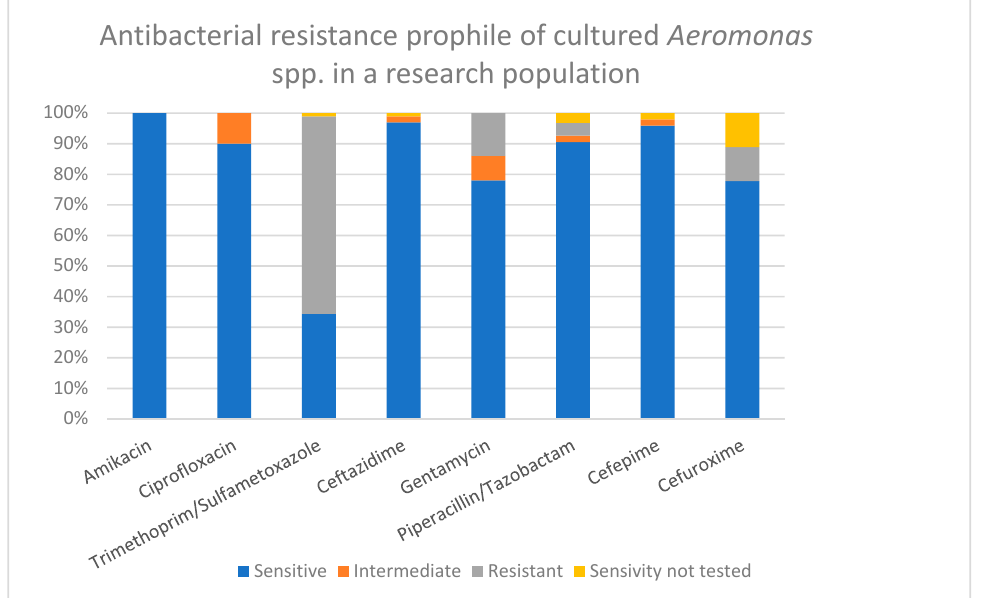
Figure 4. Antibacterial resistance profile of Aeromonas spp. isolates, %.